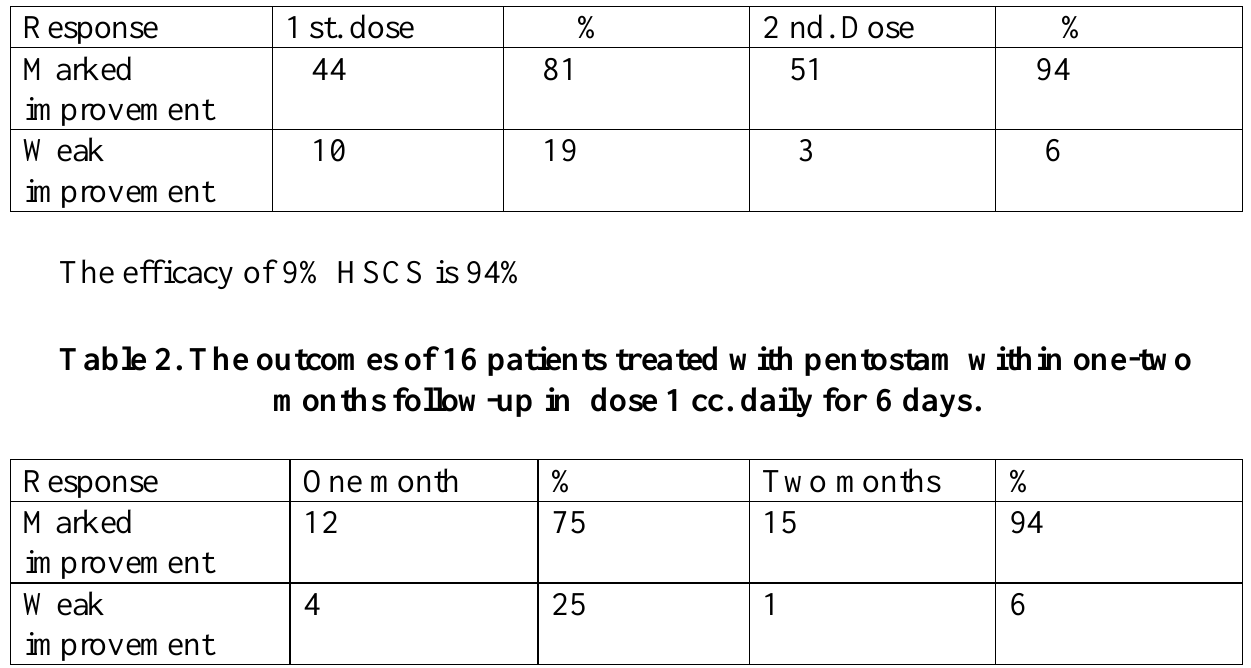
Table 1. The outcome of 54 patients treated with first and second dose of 9% HSCS within one-two months follow up.